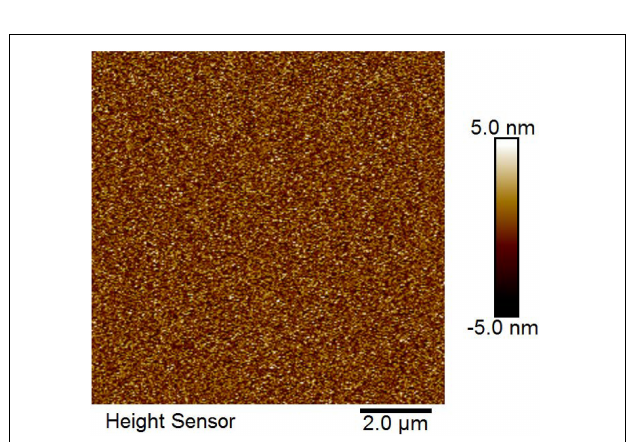
A cross-sectional TEM image of the representative Ge 1 − x Sn x